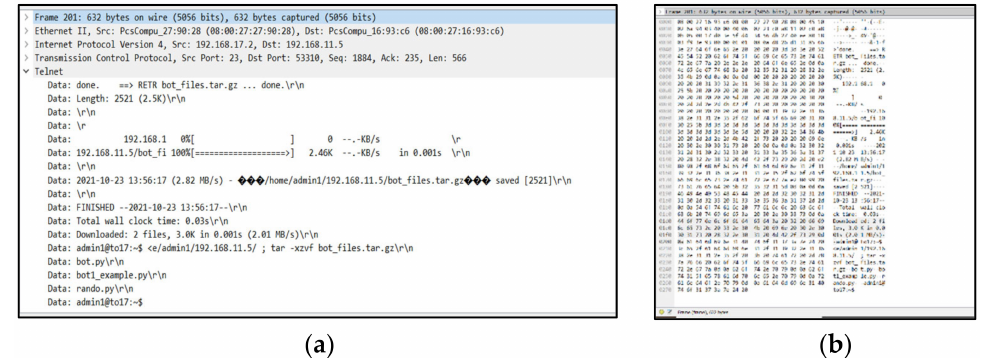
Figure 8. The investigation processes of the IoT botnet in the early stage: ( a ) focus on packet details; ( b ) focus on the hexdump of the